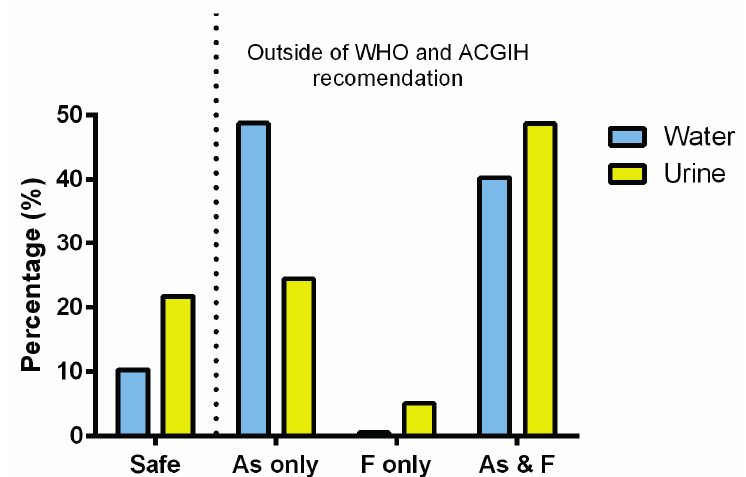
Figure 4. The percentage of water samples with arsenic and/or fluoride levels below or above the WHO maximum contaminant level of 10 µgAs/L and 1.5 mgF − /L, respectively. The percentage of urine samples with the total speciated arsenic and/or fluoride levels below or above the Biological Exposure Index value of 35 ng/mL and 2 µg/mL,